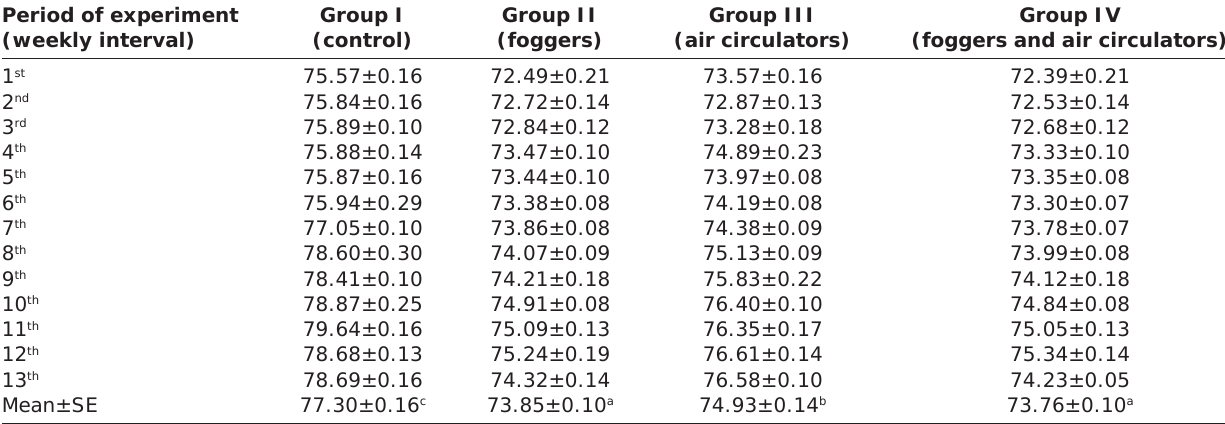
Table-5: Effect of microclimate alterations on THI of Murrah buffalo houses during summer (mean±SE). Period of experiment (weekly